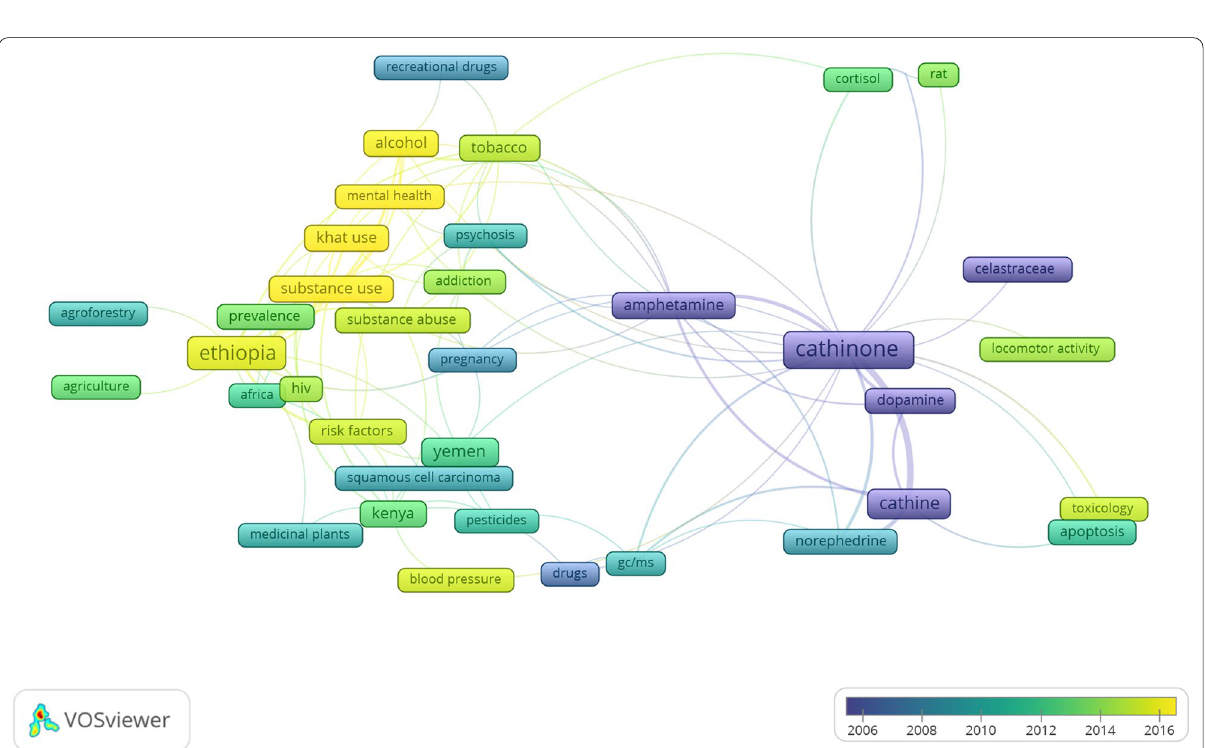
Fig. 11 Overlay visualization map of author keywords with a minimum of five or more. There are 47 keywords on the map. The size of the node denotes an important issue and is proportional to the number of occurrences in the retrieved documents. The overlay visualizations in this figure show how these research topics have progressed over the course of